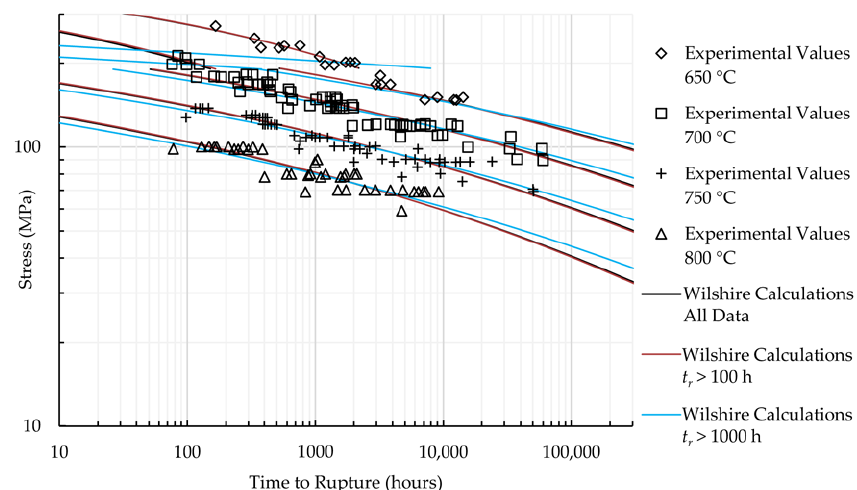
Figure 9. HR6W Wilshire equation calculations.